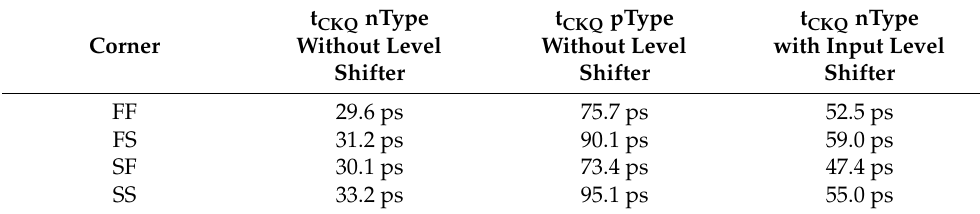
Table 6. Results of corner